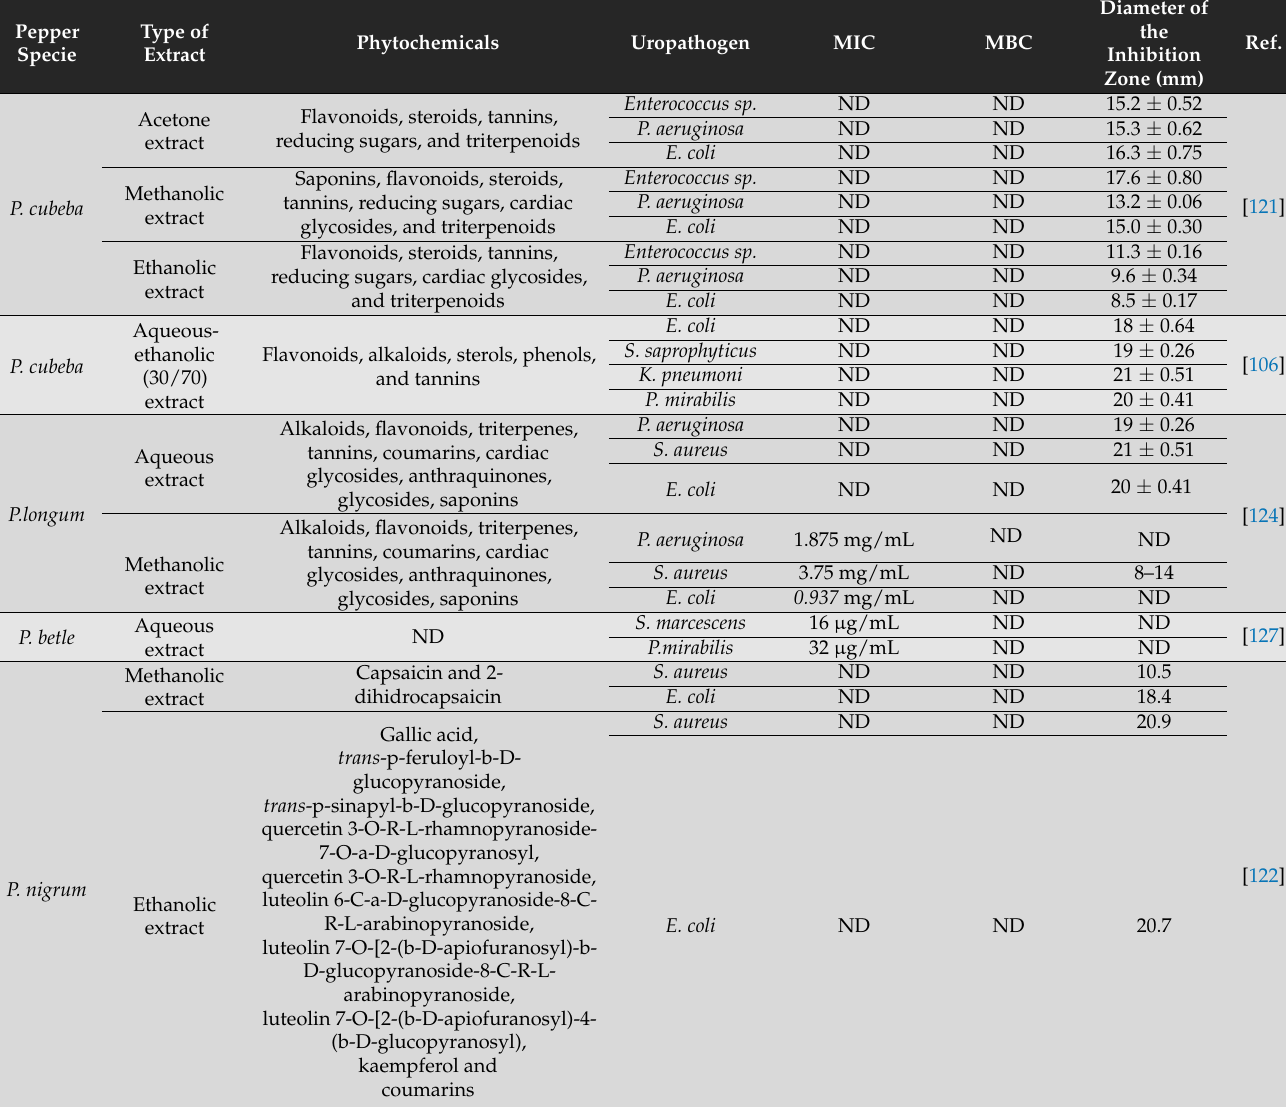
Table 5. Antimicrobial activity of pepper